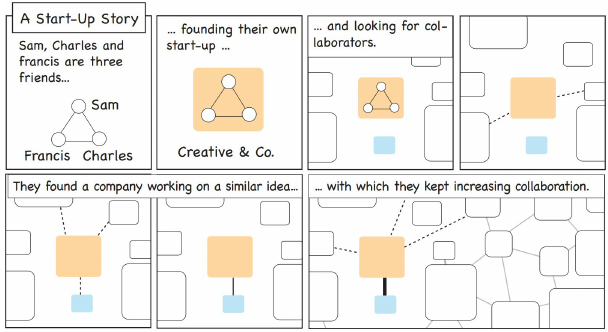
Figure 14. Bach et al. present graph comics for data-driven storytelling [35]. Image courtesy of Bach et al.